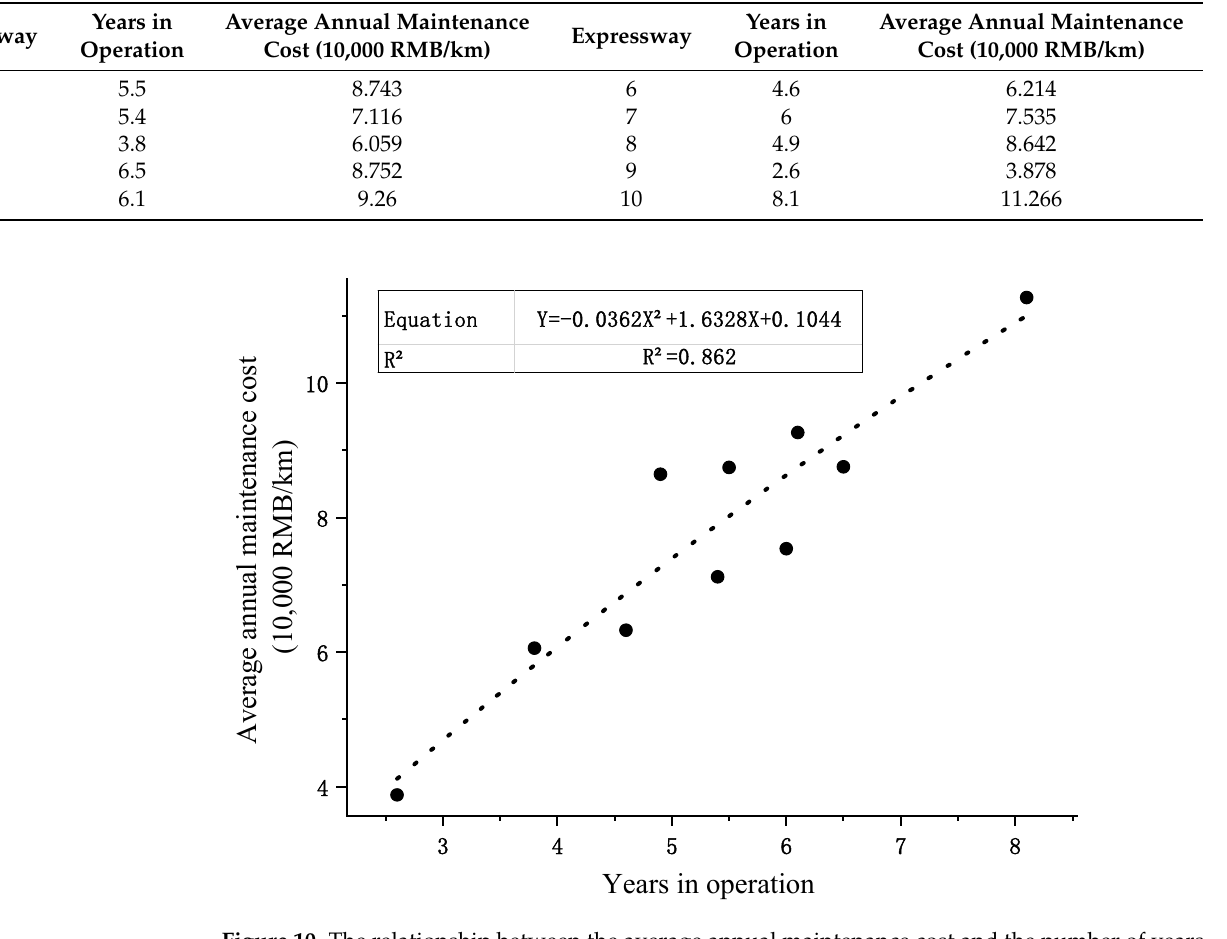
Figure 10. The relationship between the average annual maintenance cost and the number of years of operation.